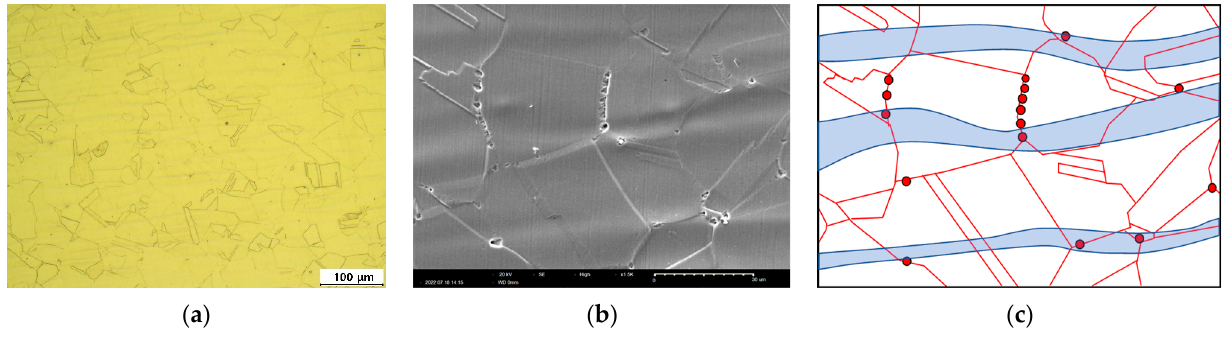
Figure 10. Corrosion morphologies of cross-section after anodic polarization test of 304LB (10% Oxalic acid, ( a ) OM (×100), ( b ) SEM (×1500)), and ( c ) schematic diagram (blue band is mechanical flow and red points are pits).